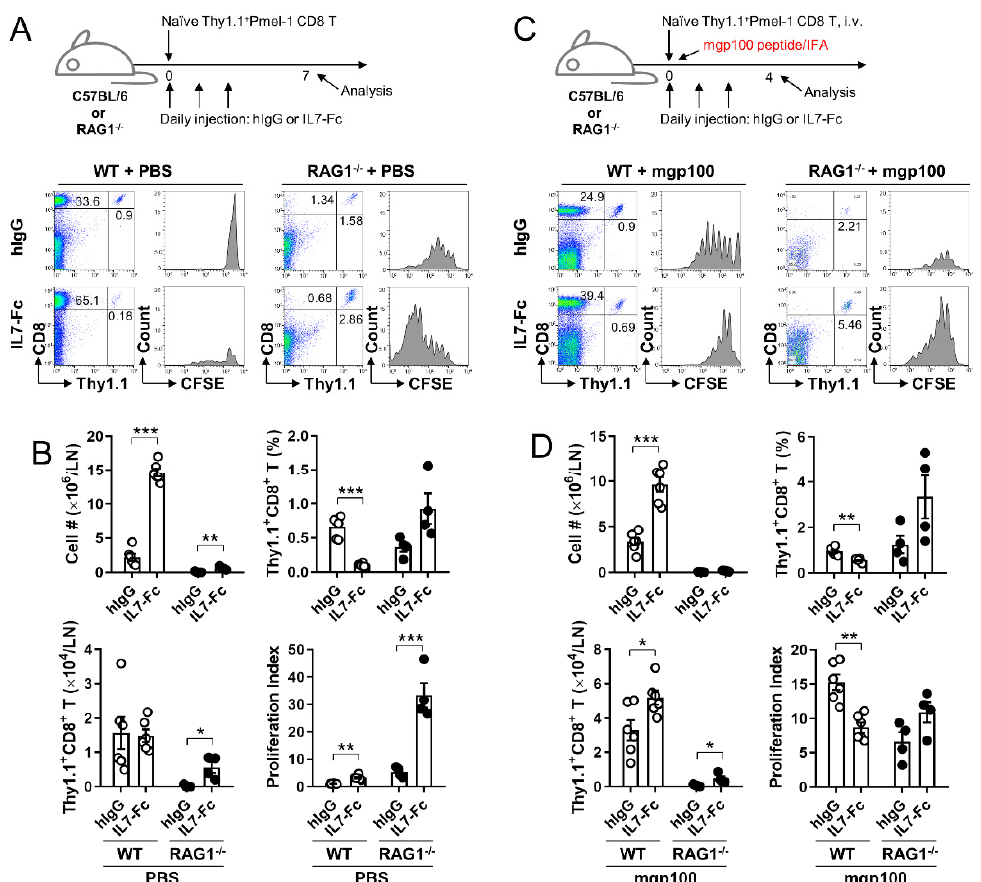
Figure 5. Effects of IL7-Fc on homeostatic and Ag-dependent proliferation of pmel-1 CD8 + T cells in non-lymphopenic and lymphopenic conditions. ( A ) WT or RAG1 − / − C57BL/6 mice were injected i.v. with 5 × 10 5 of CFSE-labeled pmel-1 Thy1.1 + CD8 + T cells and daily injected i.p. with 1 µ g of hIgG or IL7-Fc for 3 days. After seven days, a single cell suspension of inguinal LN cells was stained with anti-CD8-PE and anti-Thy1.1-PE-Cy5. CFSE dilution rates of the gated Thy1.1 + CD8 +